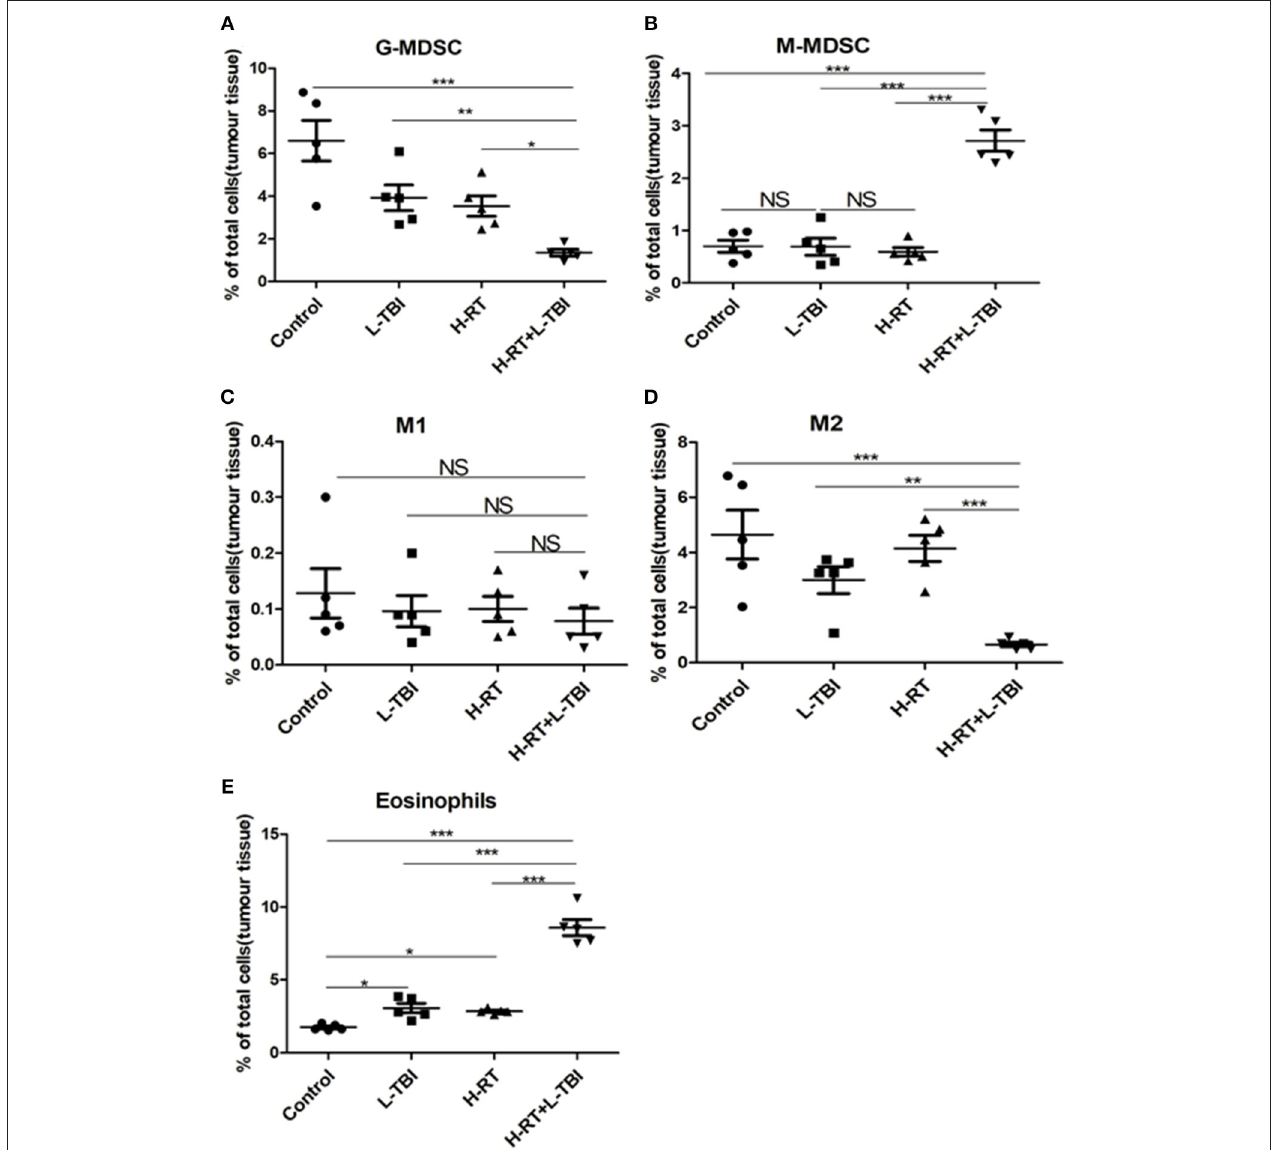
FIGURE 6 | Immunosuppressive microenvironment effects of H-RT and L-TBI combination therapy on 4T1 tumor-bearing mice. The percentage of the G-MDSCs (defined as CD45 + CD11c − CD11b + Ly6G + Ly6c low ) (A) , M-MDSCs (defined as CD45 + CD11c − CD11b + Ly6G − Ly6c hi ) (B) , M1 (defined as CD45 + CD11b + F4/80 + CD206 − ) (C) , M2 (defined as CD45 + CD11b + F4/80 + CD206 + ) (D) , and Eosinophils (defined as Siglec-F + Gr1 low ) (E) were analyzed by flow cytometry analysis. Data are representative charts or the percentages of individual subjects. Data are expressed as mean ± SE of 5 mice/group. The statistical significance of differences